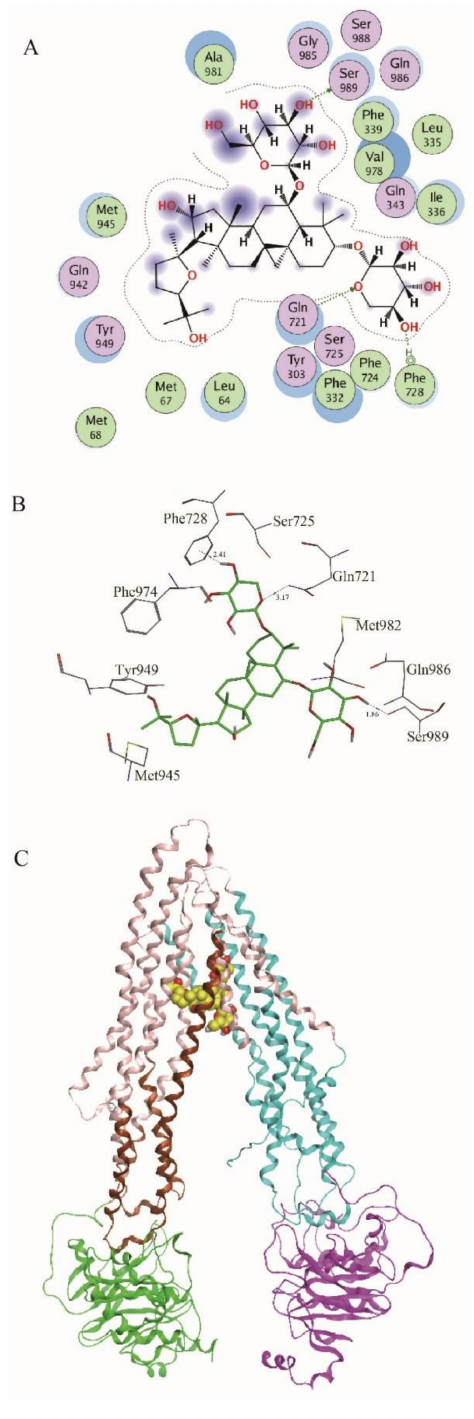
Figure 4. Molecular docking experiment. ( A ) 2D interaction map of the interactions between ASIV and P-gp; ( B ) the binding mode of ASIV and P-gp structure; ( C ) the whole view of the binding mode of ASIV and P-gp